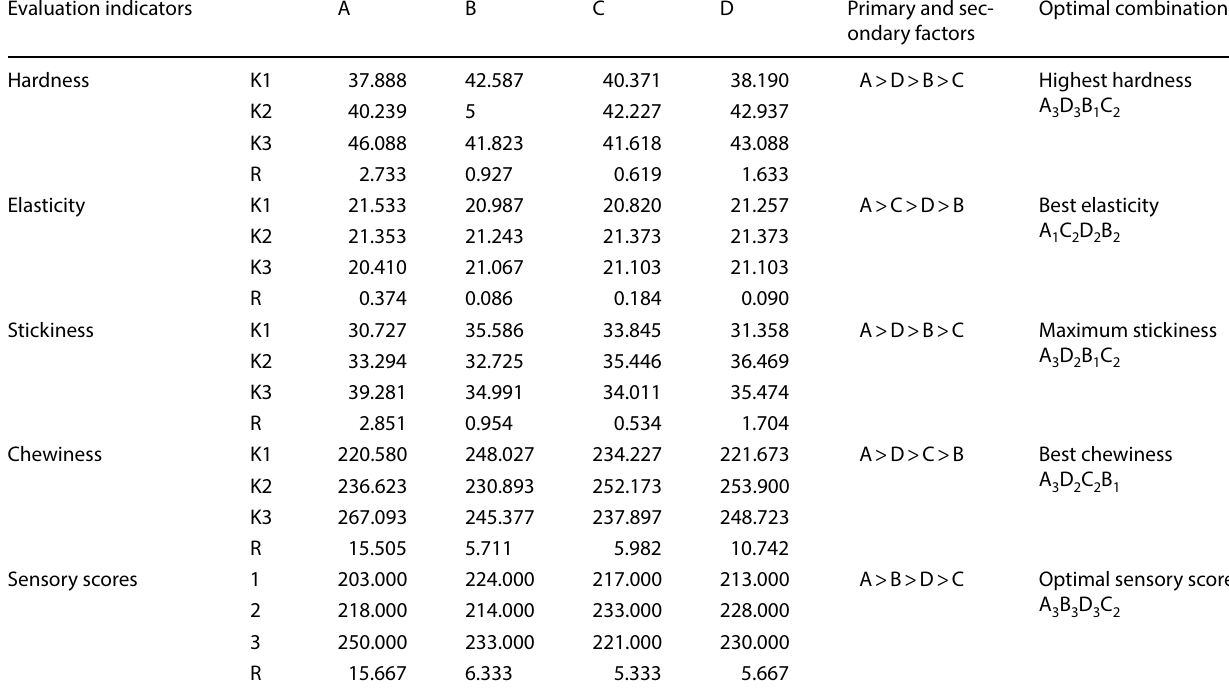
Table 5 Orthogonal analysis of OP gel gummies preparation Evaluation